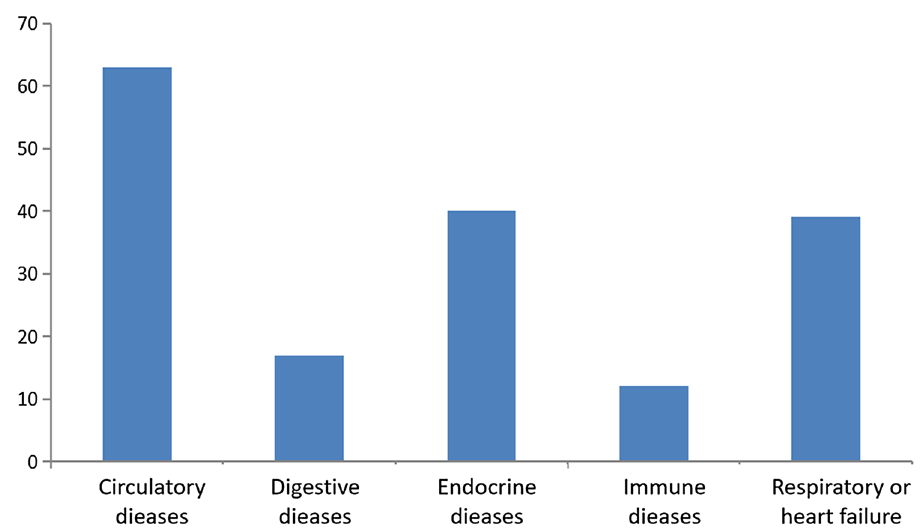
Figure 2. Concomitant diseases in patients with CEA levels above 5